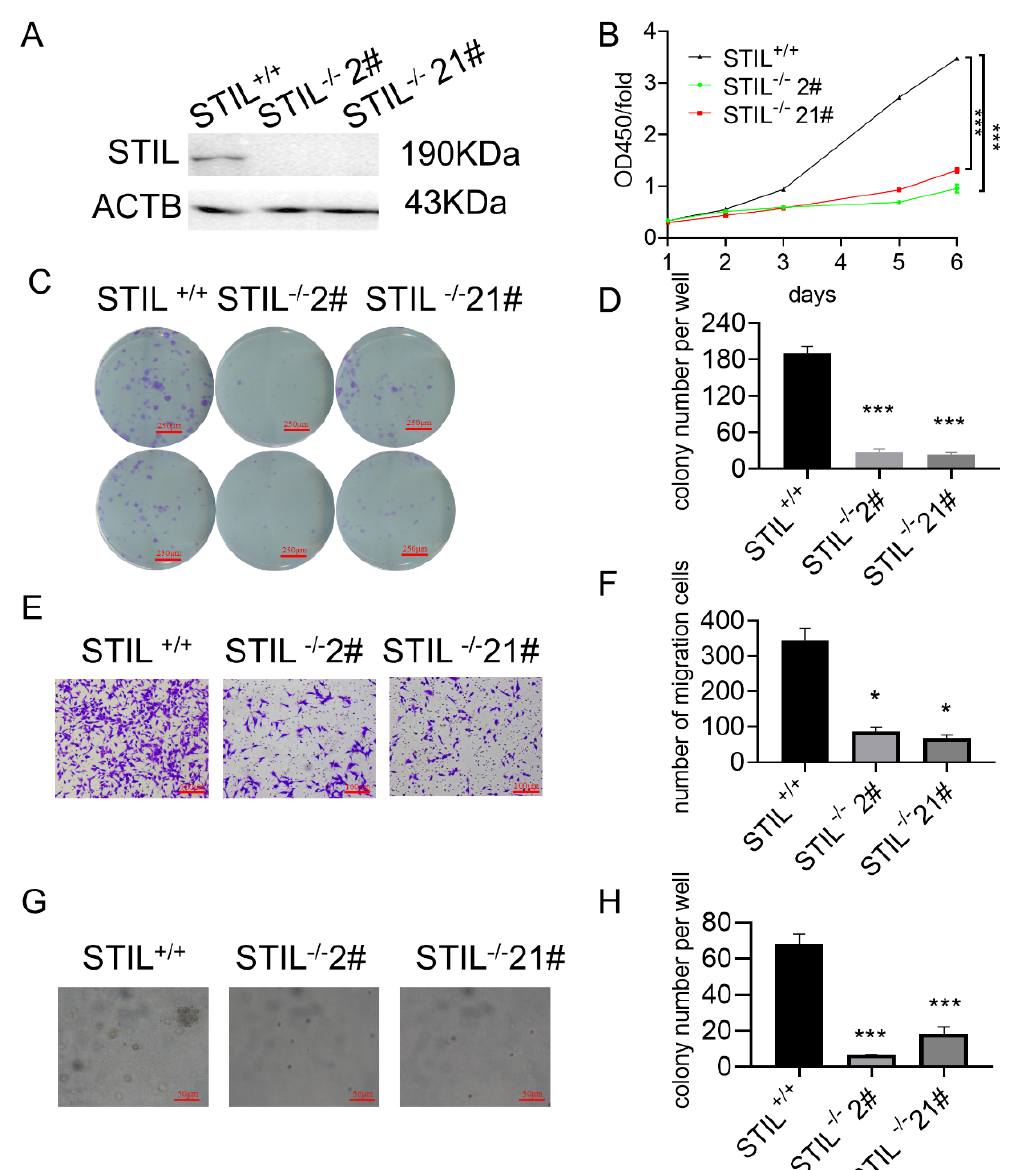
Figure 3. In the UMUC3 cell line, knockout of STIL inhibited BC tumorigenesis in vitro. ( A ) After screening by Western blot, the exact STIL knockout cells (STIL − / − 2# and STIL − / − 21#) were obtained. ( B ) CCK-8 assay. ( C ) Representative microscope images and ( D ) quantitative analysis of colony formation assays. ( E ) Representative microscope images and ( F ) quantitative analysis of transwell migration assay. ( G ) Representative microscope images and ( H ) quantitative analysis of soft agar assay. All experiments were conducted with the following groups: control group (STIL +/+ cells) and experimental groups (STIL − / − 2# cells and STIL − / − 21# cells). CCK-8 assay, Cell Counting Kit-8 assay (* p < 0.05 and *** p < 0.001).